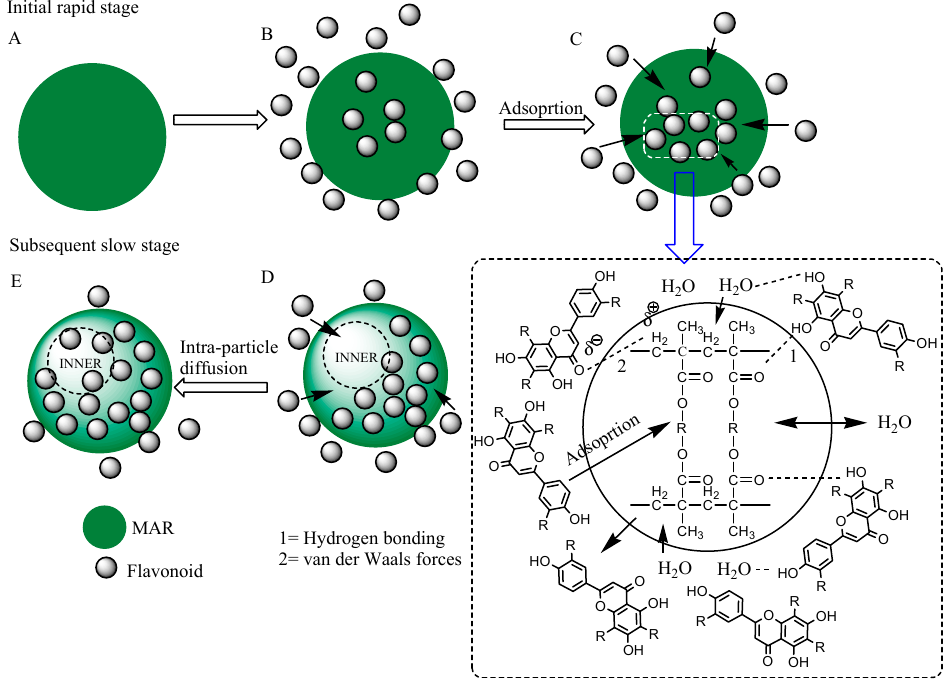
Figure 2. Schematic diagram of the adsorption process of OPL total flavonoids on XAD7HP resin.